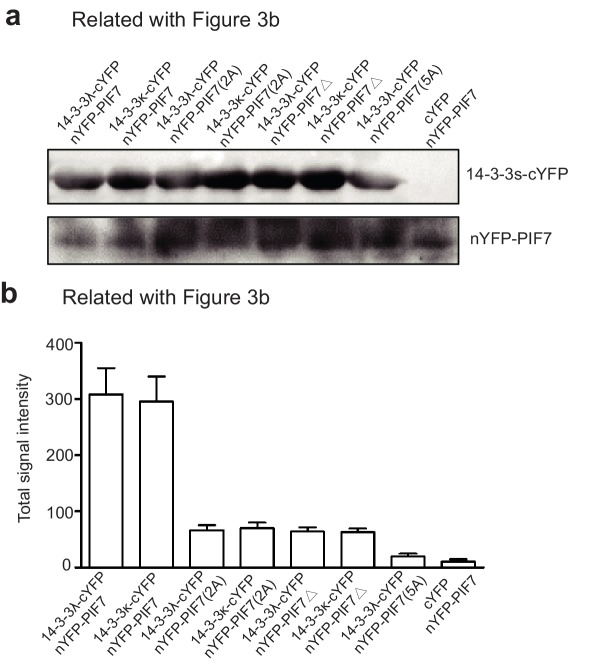
Expression of 14-3-3 proteins and PIF7, and quantification of YFP signals in Figure 3b.(a) Anti-GFP antibody from Covance (MMS-118P-200G) was used to detect the nYFP-tagged protein. Anti-14-3-3 antibody from Agrisera (AS12 2119) was used to detect 14-3-3 λ-cYFP. The tobacco leaves were collected for western blotting 36 hr after infiltration. (b) Quantification of the YFP signals in Figure 3b.